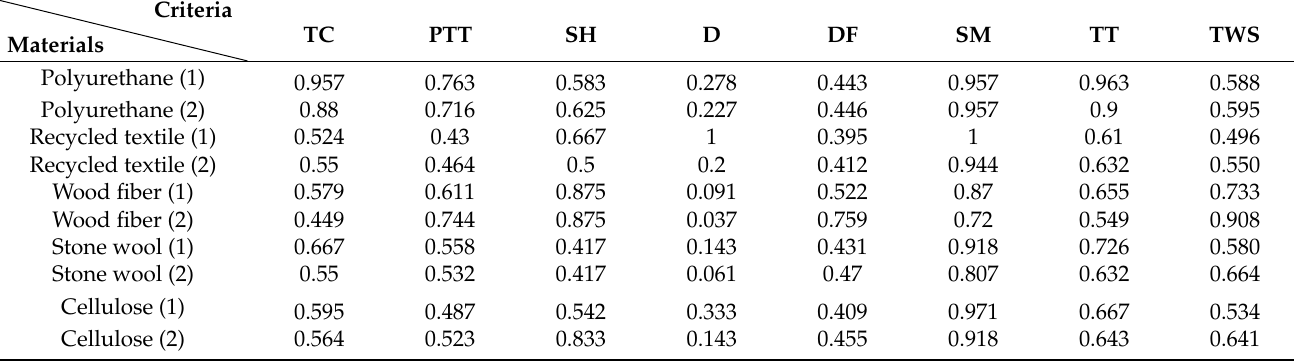
Table 8. The results of Normalization Procedure